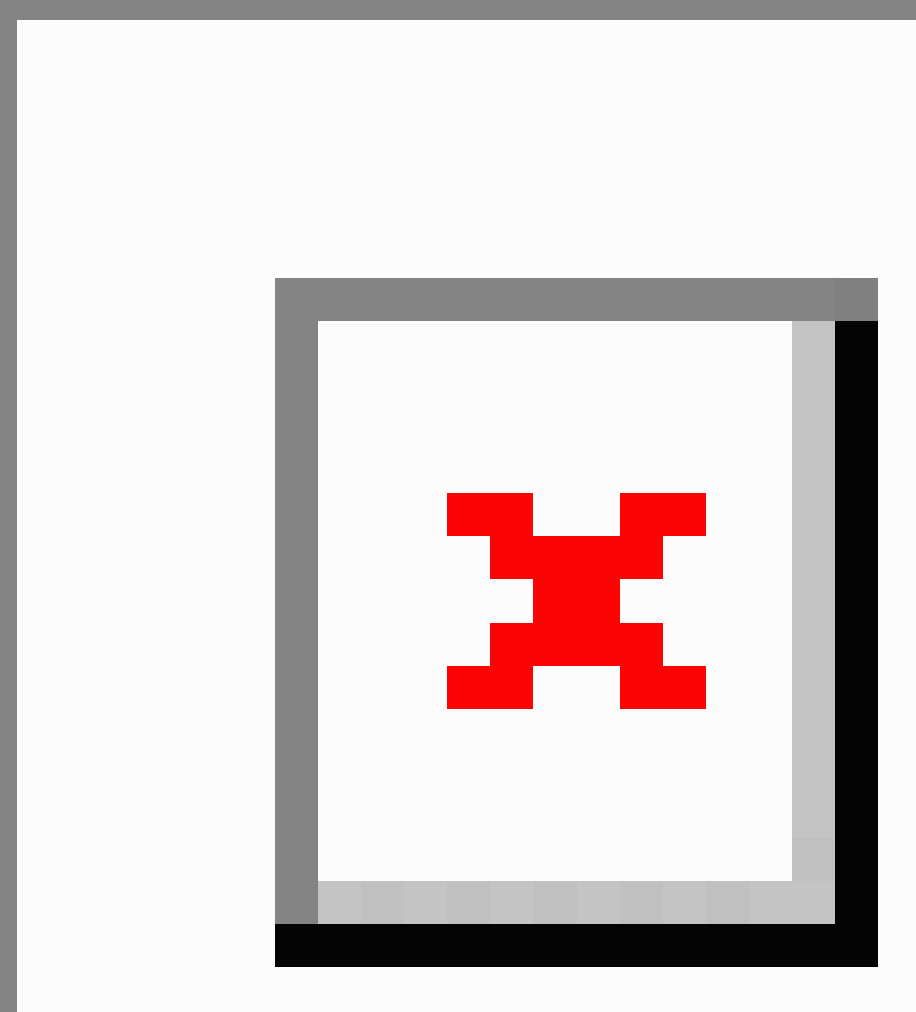
Figure 2. Ranking of top 20 actors contributing to Alcohol Help Center.